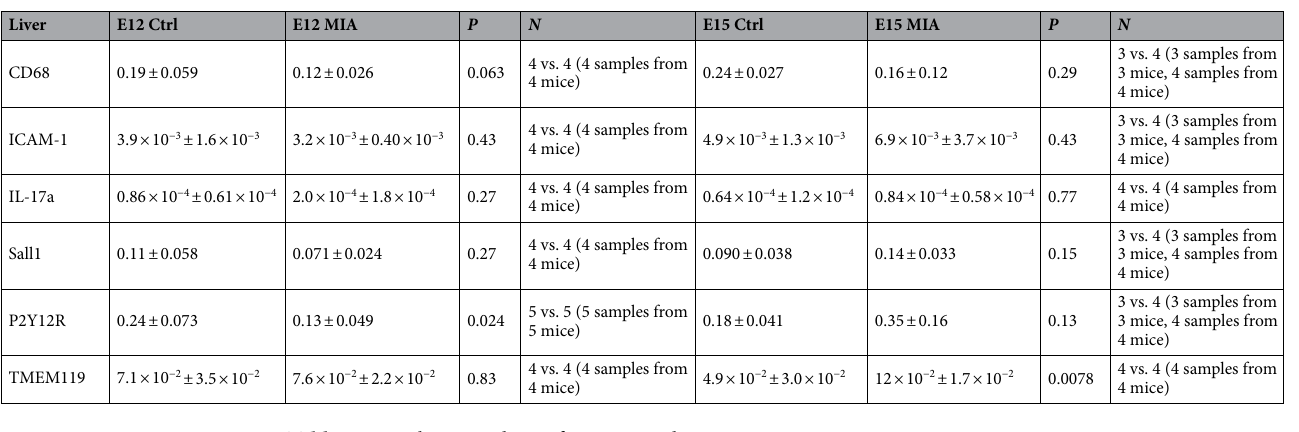
Table 3. Cytokines analysis of P10